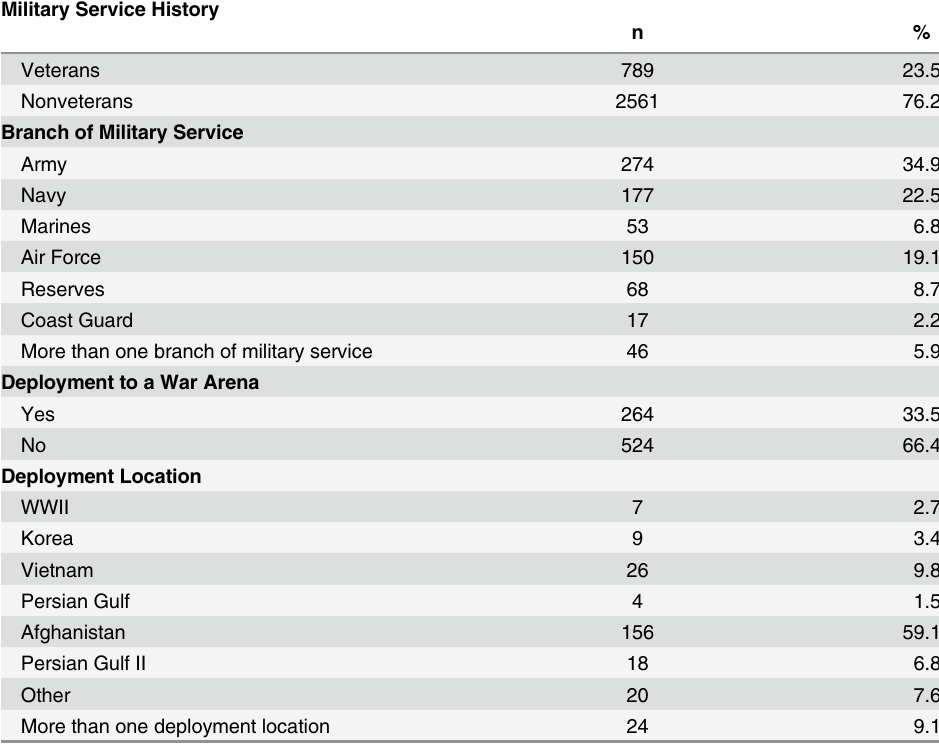
Table 3. Military History among Adults with ALS (October 19, 2010 – December 31,